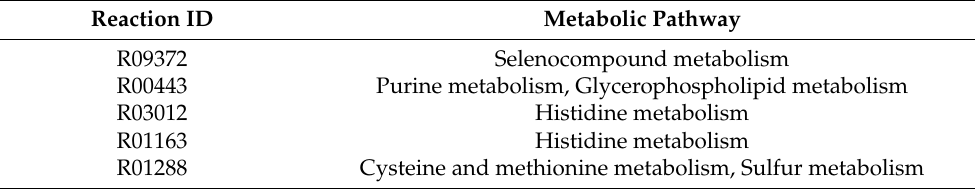
Table 3. Essential reactions of the m-DAG of “ Ca. Nasuia deltocephalinicola” str.